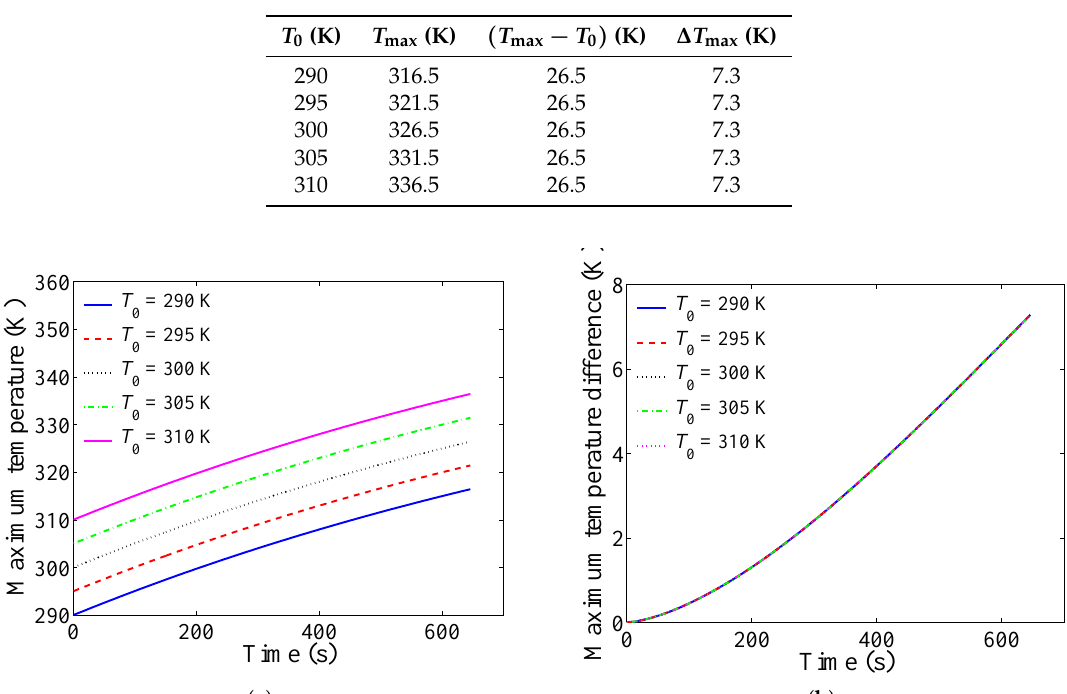
Table 5. Numerical results for various inlet air temperatures.